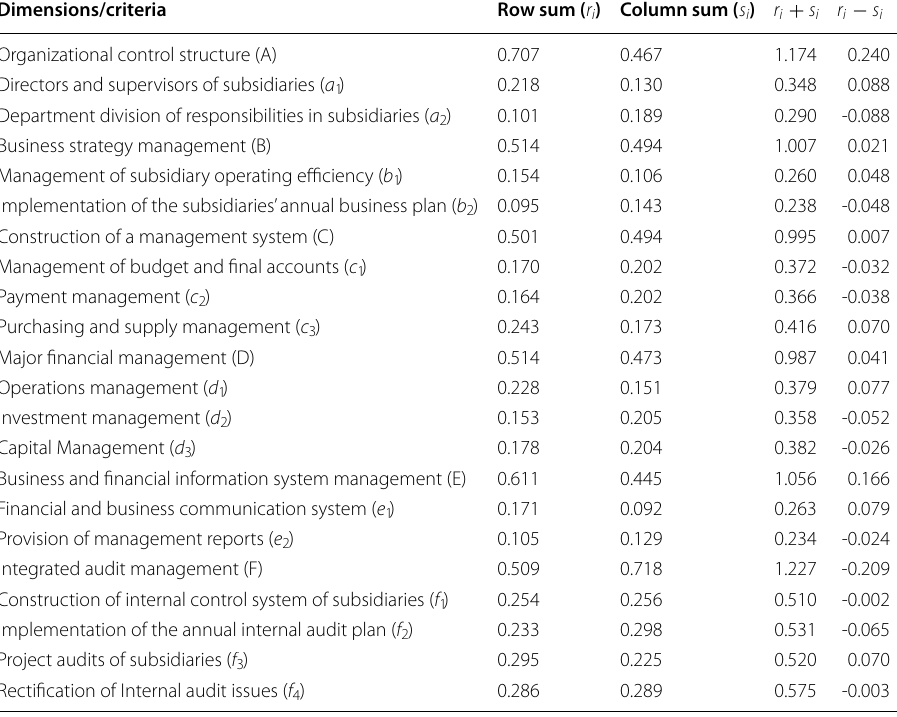
n n ( z 20 ij − z 19 ij i = 1 j = 1 (cid:30) (cid:31) (cid:31) (cid:30) (cid:30)